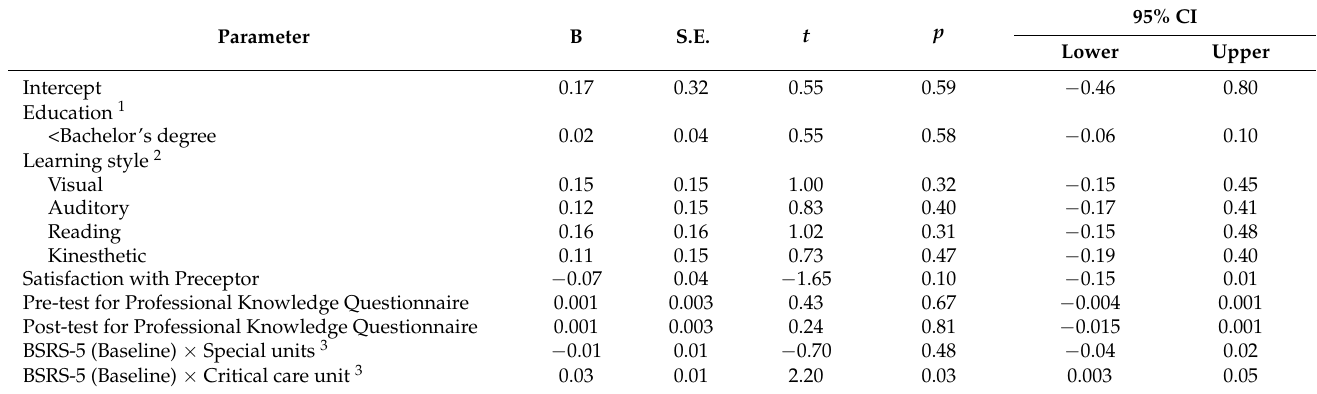
Table 5. GLM analysis of the NGN turnover leave within 90